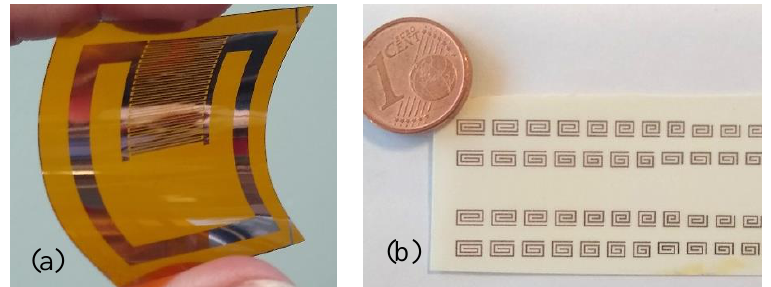
Figure 18. Tags realized by lithography. ( a ) Flexible sensing resonator structure (copper on Kapton). ( b ) Spiral resonator arrays (copper on 168 μm-thick Rogers 4350B).